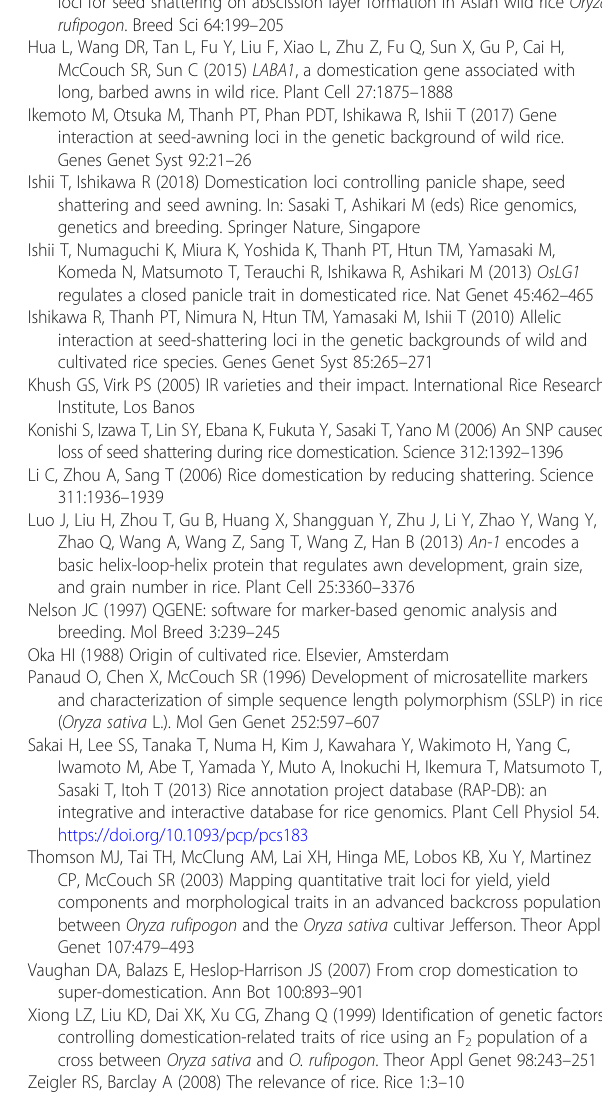
Additional file 2: Figure S1. Graphical genotype of the J5 backcross recombinant inbred line. Figure S2. Frequency distributions of awn lengths in the 1st to 5th spikelet positions in BC 3 F 2 population between O. rufipogon W630 and the J5 line. Figure S3. Spikelet morphology of the eight genotypes of BC 3 F 3 plants together with O. rufipogon W630, J5 line and O. sativa IR36. Figure S4. Awn lengths (means ± SD) of the 1st to 4th spikelets of eight homozygous genotypes in the wild genetic